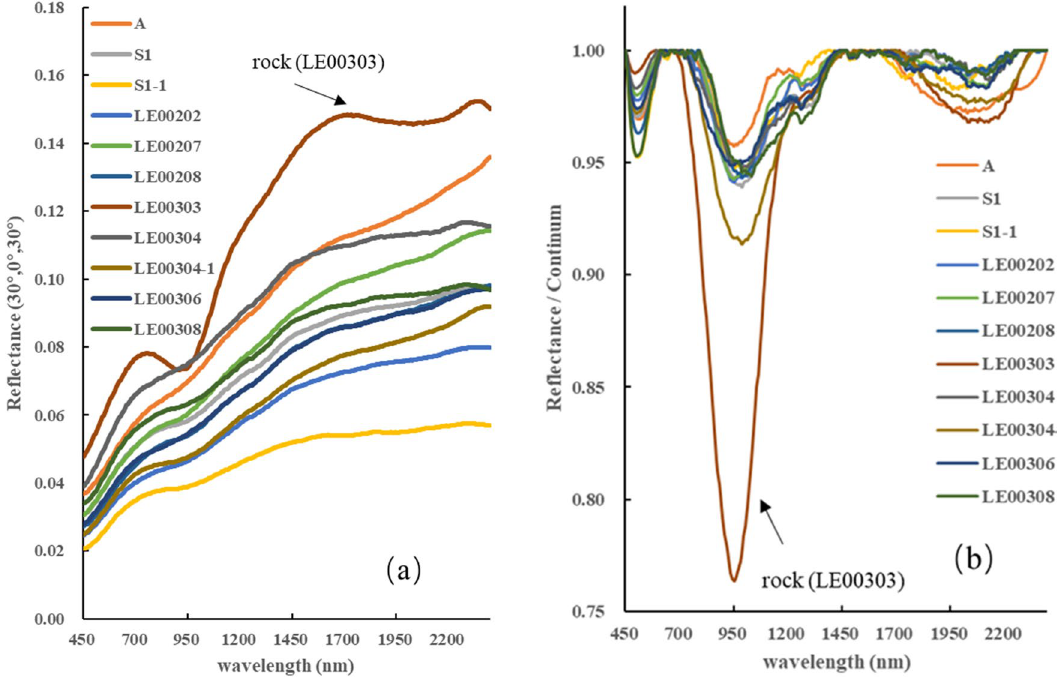
Figure 2. Examples of VNIS spectra measured by Yutu-2 rover. ( a ) The reflectance data with photometric correction and smoothing. ( b ) The spectra after continuum